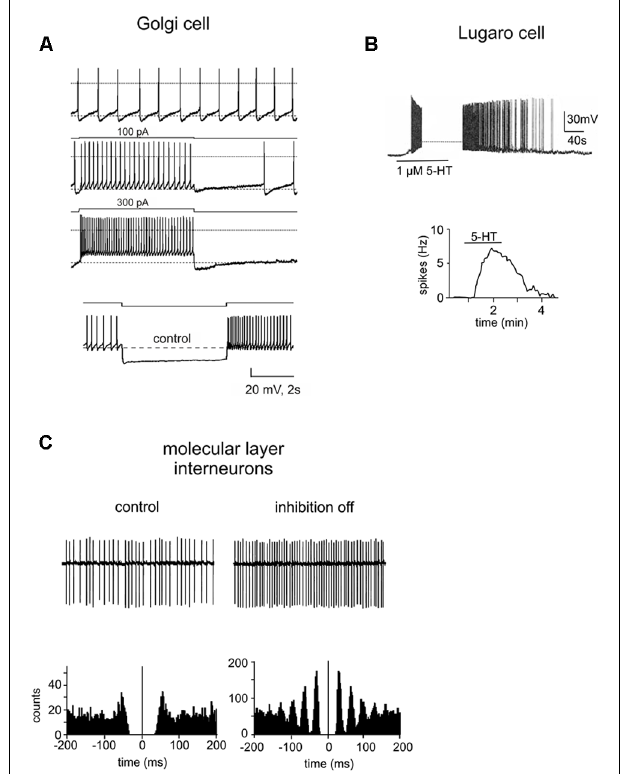
FIGURE 4 | Intrinsic properties of cerebellar GABAergic neurons. (A) Electroresponsiveness of a Golgi cell. The neuron shows low-frequency pacemaking activity and, upon depolarizing current injection, high-frequency spike discharge. Spike discharges are followed by an afterhyperpolarization and a silent pause. Upon hyperpolarizing current injection, the Golgi cell shows sagging inward rectification, followed by a post-inhibitory rebound. Adapted from Forti et al. (2006). (B) Whole-cell current-clamp recording in rat cerebellar slices demonstrated that the spontaneously inactive LC was reversibly excited by serotonin (1 µ M). Below, summary of the effect of serotonin on the firing frequency of a LC. Adapted from Dieudonné and Dumoulin (2000). (C) Cell-attached patch-clamp recording from a ML interneuron under control conditions and during the block of inhibition. Below, autocorrelation of action potential trains from the corresponding recordings. Note that the block of inhibition causes a marked increase in the regularity of firing. Adapted from Hausser and Clark